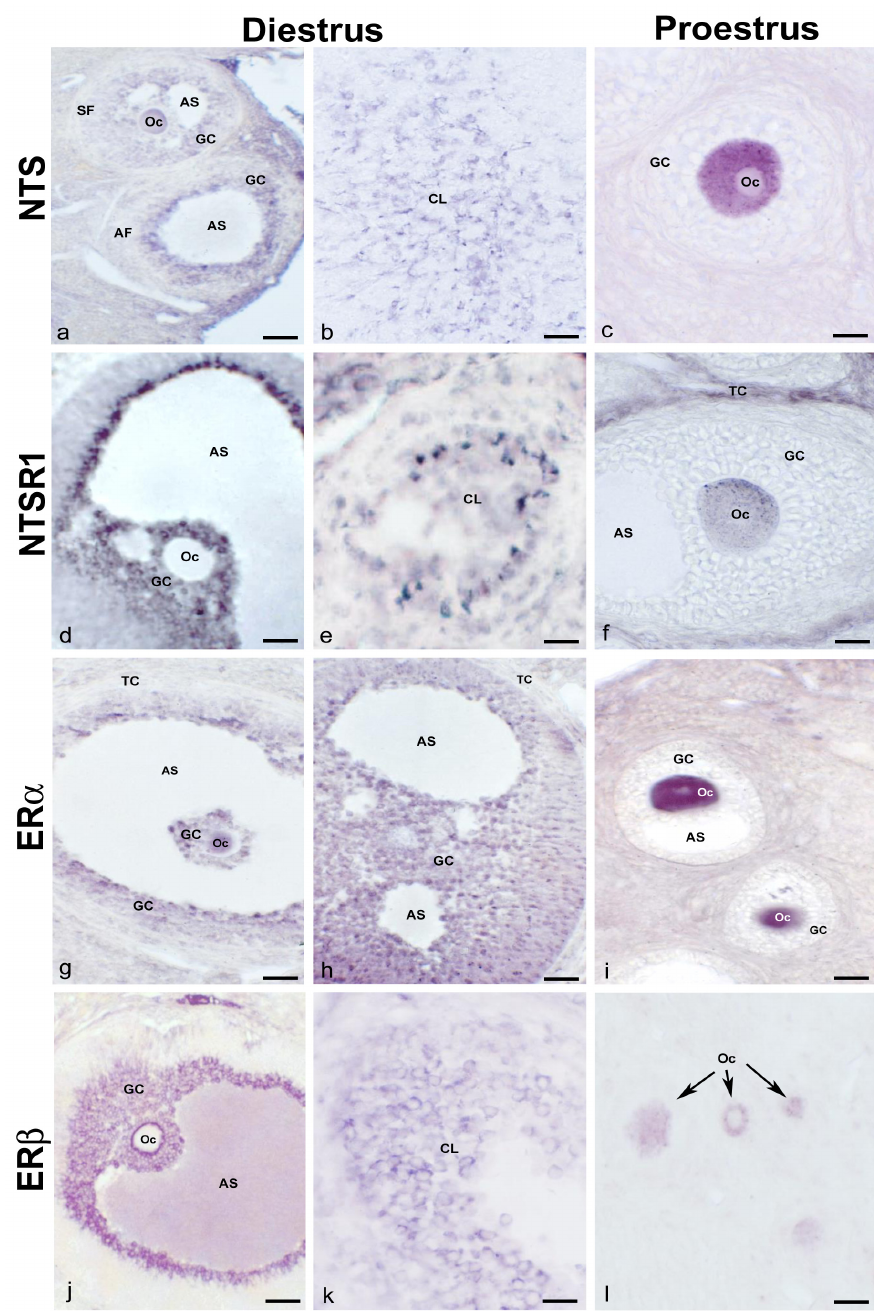
Figure 1. NTS, NTSR1, and ER α / β in normal cycling adult females. Representative images of the ovaries of cycling adult females showing NTS-ir in oocytes, granulosa cells from different follicles, the corpus luteum in diestrus phase ( a , b ), and in the oocyte cytoplasm of a multilayered primary follicle in proestrus phase ( c ); NTSR1-ir in granulosa cells of an antral follicle and cells of corpus luteum in diestrus phase ( d , e ), and the cytoplasm of the oocyte of a secondary follicle as well as in theca cells in proestrus phase ( f ); ER α -ir in the oocytes and granulosa cells of different follicles in the diestrus phase ( g , h ), and the cytoplasm and nucleus of the oocytes from secondary follicles in the proestrus phase ( i ); and ER β -ir in the granulosa cells of an antral follicle and cells of the corpus luteum in the diestrus phase ( j , k ) and the cytoplasm of oocytes from primary follicles in the proestrus phase (arrows) ( l ). AF: antral follicle; AS: antral space; CL: corpus luteum; GC: granulosa cells; Oc: oocyte; SF: secondary follicle; TC: theca cells. Scale bars: ( a , b ): 50 µm; ( c , f ): 20 µm; ( d , g , h , j ): 60 µm; ( e , i , k ): 30 µm; and ( l ): 35 µm.